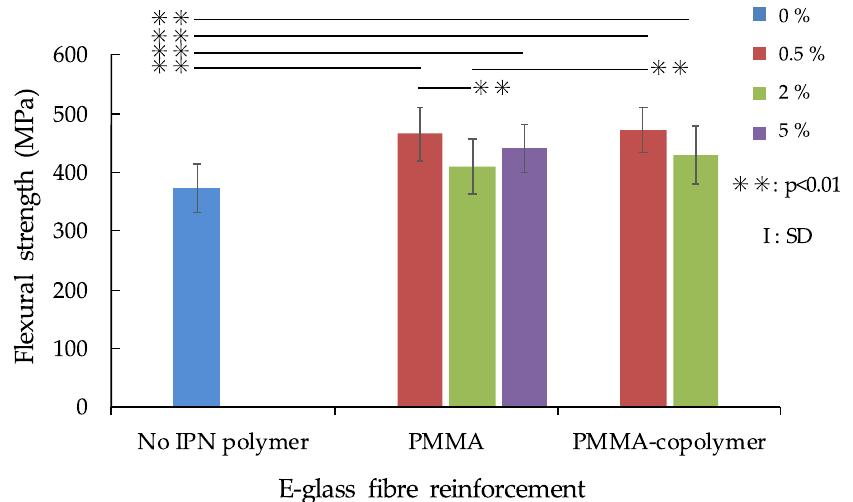
Figure 4. Mean flexural strength of IPN thermoplastic resin with E-glass fibre reinforcement. 3.2. SEM Observation SEM photographs of the penetration of CP into polymerized everStick posts revealed with diiodomethane are shown in Figure 5. As shown in Figure 5a, hand-light cured spec- imen shows almost no penetration layer after 1 min immersion, however, after 5 min and 1 h one layer of penetration is seen. After 24 h, the penetration layer of CP was observed in a deeper layer and everywhere in the specimen. On the other hand, the oven-cured specimens did not show a noticeable penetration layer after different immersion times ranging from 1 min to 24 h as shown in Figure 5b.